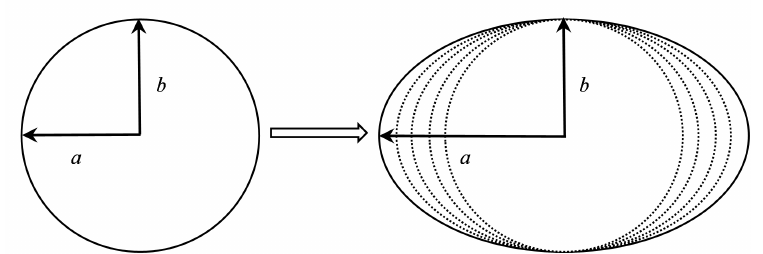
Figure 12. Schematic of shells with different ratios between the a and b axes.